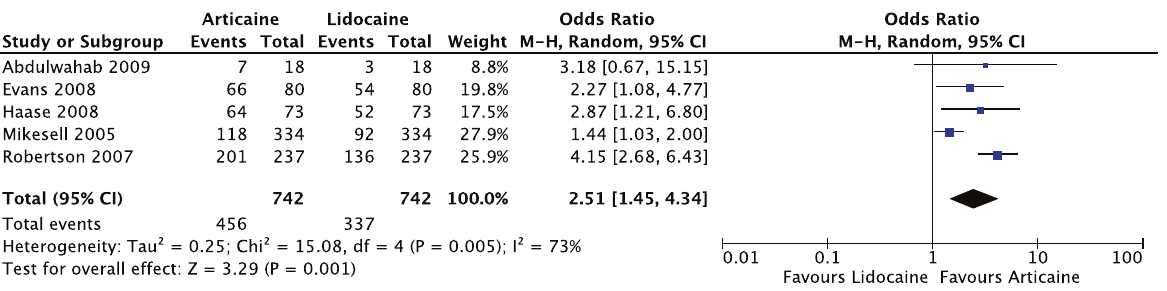
Fig. 12 Forest plot — studies with pre-operative healthy teeth. Articaine had 2.51 times likelihood of anaesthetic success of lidocaine.